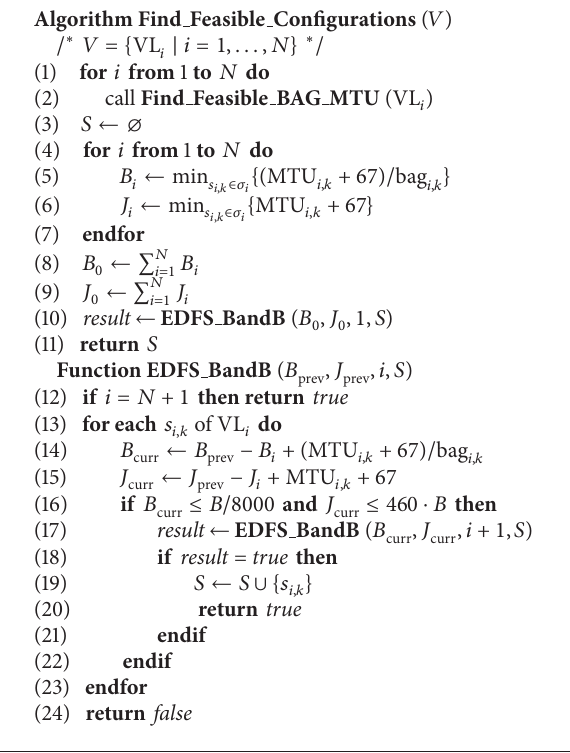
Algorithm 2: The proposed algorithm for AFDX-CONF .